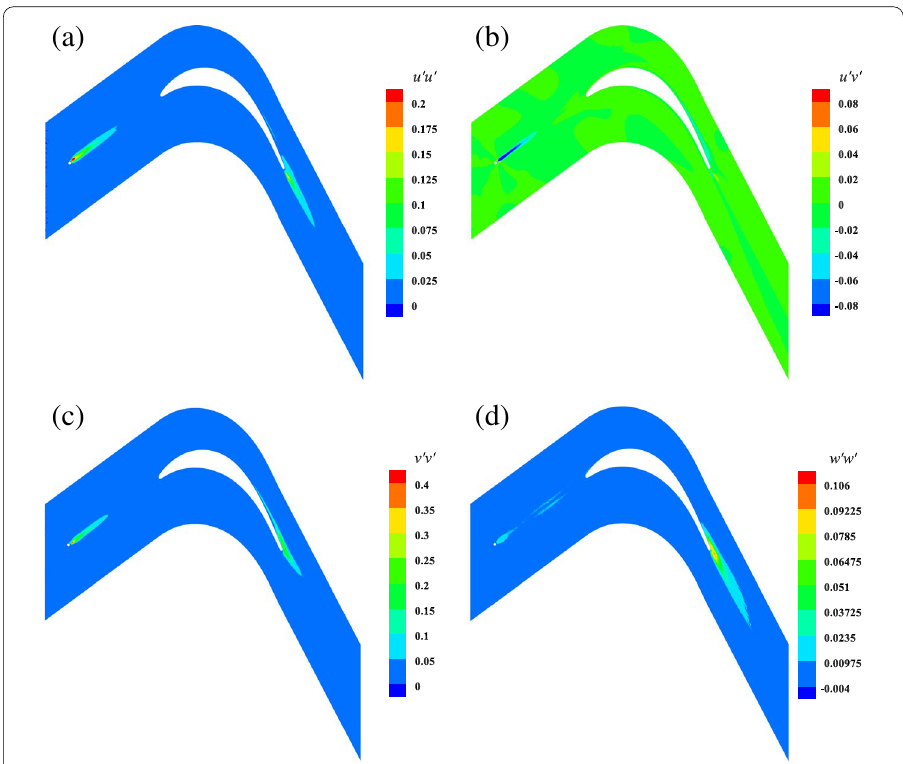
Fig. 9 Time- and spanwise-averaged Reynolds stress with disturbed inflow condition: ( a ) u’u’ ; ( b ) u’v’ ; ( c ) v’v’ ; (d)